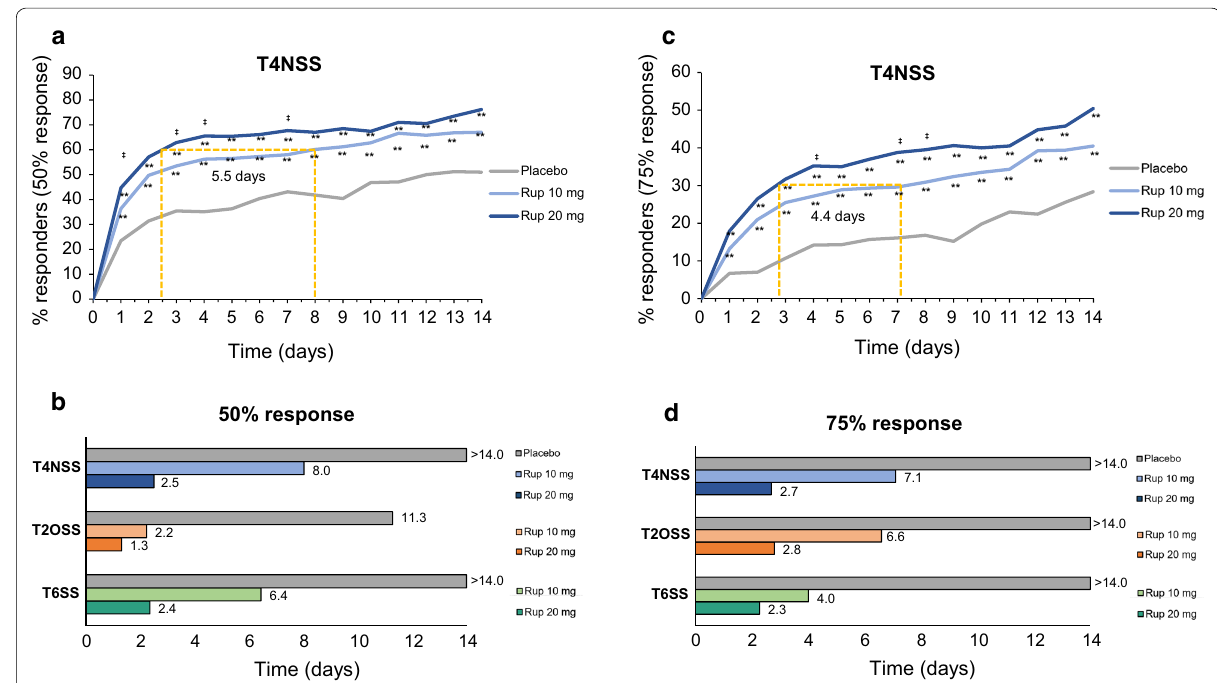
Fig. 3 Time to achieve 50% and 75% response after treatment with rupatadine 10 mg or 20 mg for T4NSS, T2OSS, and T6SS. a Proportion of responders over time to achieve the 50% response in T4NSS. c Proportion of responders over time to achieve 75% response in T4NSS. b Time (days) to achieve the 50% response (T4NSS, T2OSS, and T6SS). d Time (days) to achieve the 75% response (T4NSS, T2OSS, and T6SS). T4NSS Total 4 Nasal Symptom Score, T2OSS Total 2 Ocular Symptom Score, T6SS Total 6 Symptom